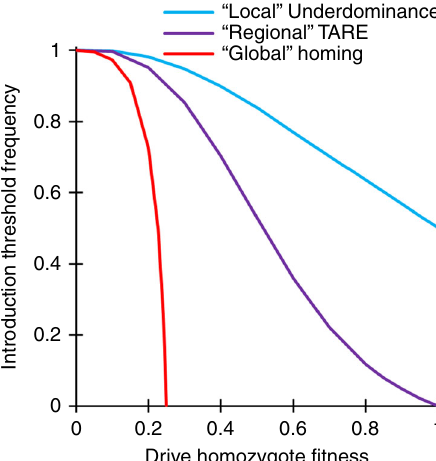
Fig. 7 Introduction threshold comparison. The chart shows the introduction threshold frequencies for drive homozygotes as a function of the drive fi tness cost in homozygotes using a deterministic model of a single panmictic population. These thresholds represent unstable equilibria above which the drive increases in frequency and below which the drive is removed. All drives are idealized, and the underdominance system uses a single locus with heterozygote disadvantage 44,51